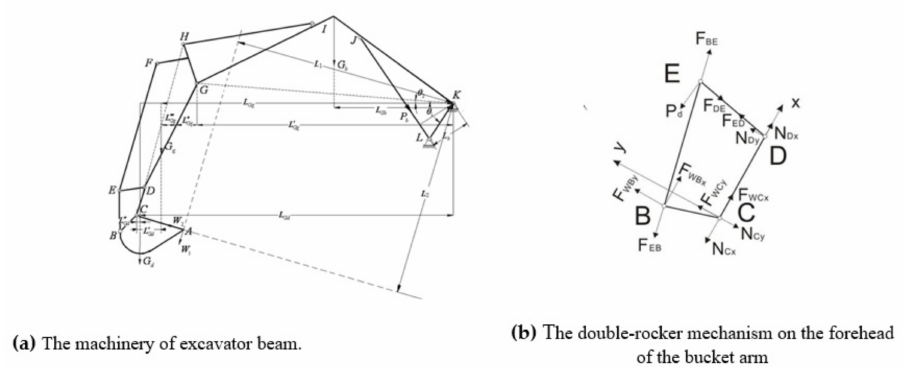
Figure 4. The dynamic model of the excavator